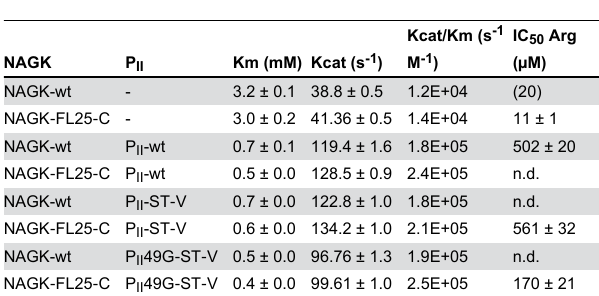
Table 1. Kinetic constants and arginine inhibition properties (IC ) of NAGK-wt or NAGK ‑ FL25 ‑ C in the absence or 50 presence of various P II